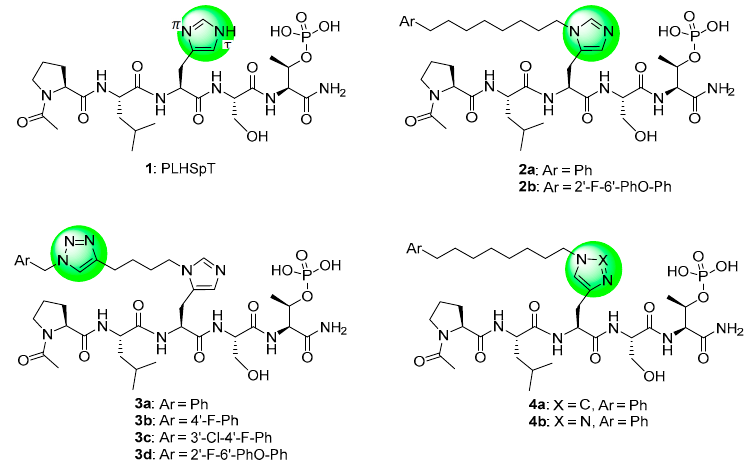
Figure 1. The polo-box interacting protein 1 (PBIP) pT78-derived peptide 1 and related derivatives discussed in the text.